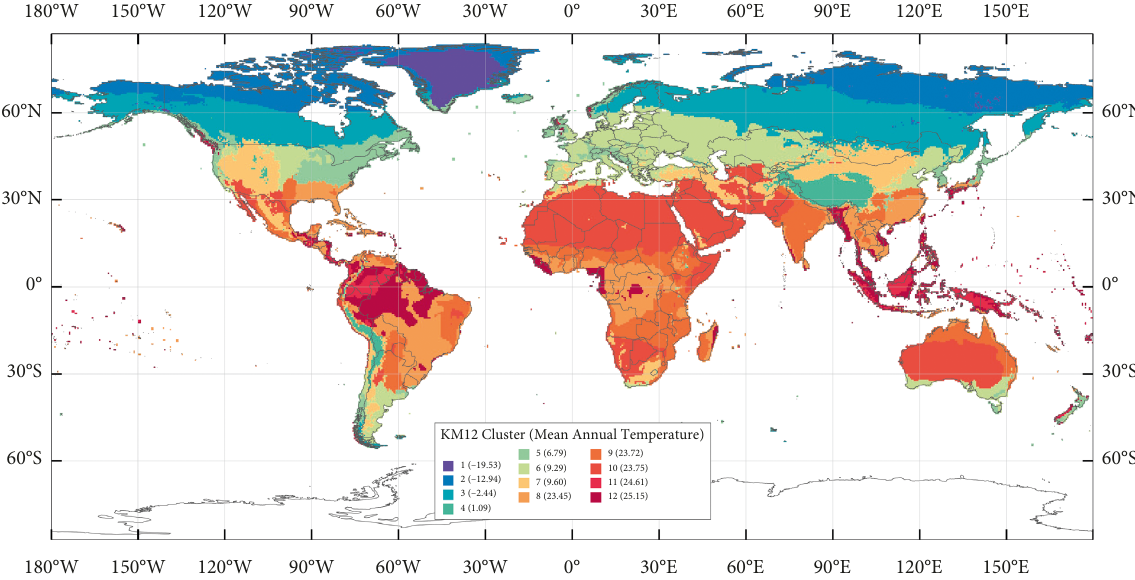
Figure 6: 12-cluster solution (KM12) of k -means